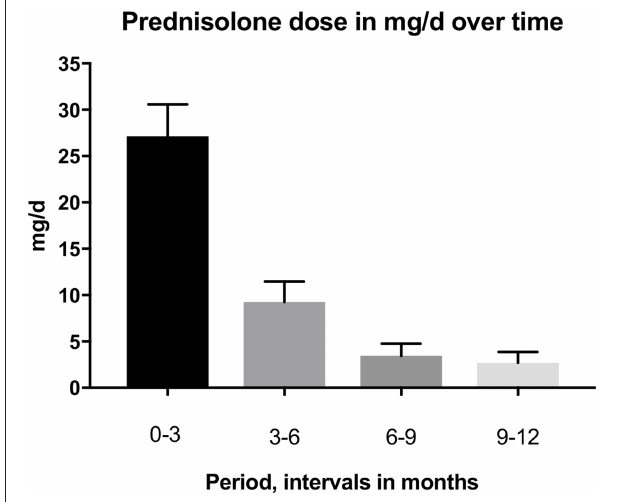
FIGURE 1 | Mean dose prednisolone per interval with the standard error of mean SEM.